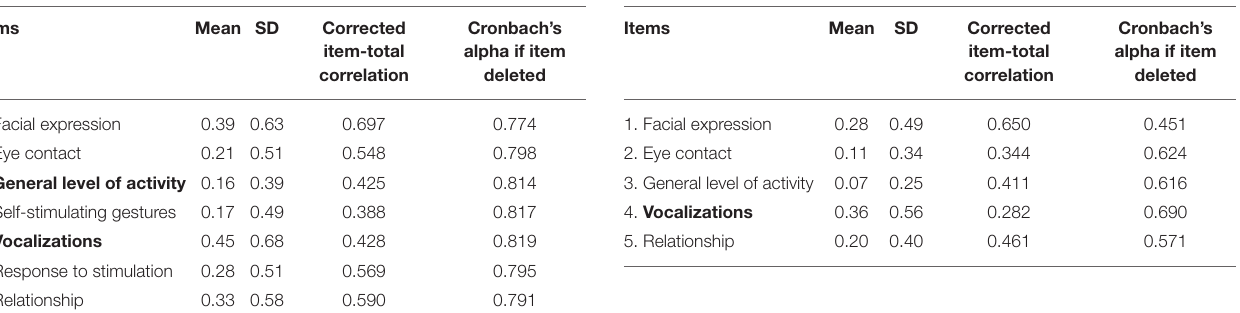
TABLE 5 | Internal consistency of the m-ADBB scale in the second